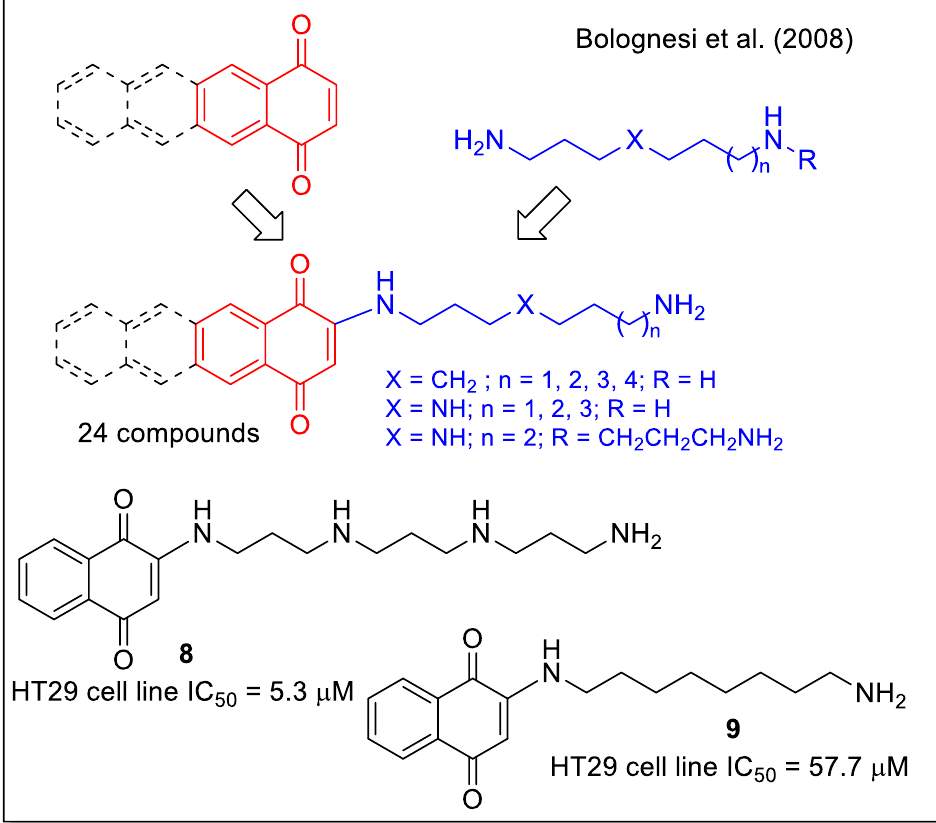
Figure 5. 1,4-Naphtoquinone-polyamine hybrids as reported by Bolognesi et al. [32]. Triazole is a chemically stable and biocompatible group, used as amide bioisostere and able to increase the water solubility of a molecule when inserted into its